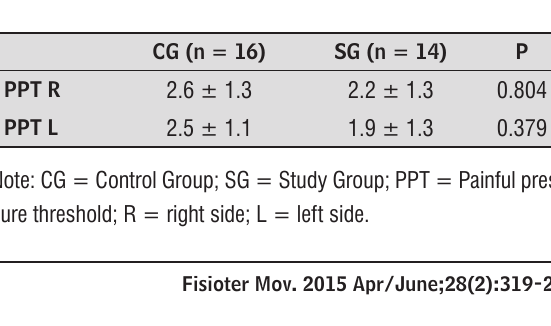
Table 3 - Comparison of painful pressure threshold between groups and body sides